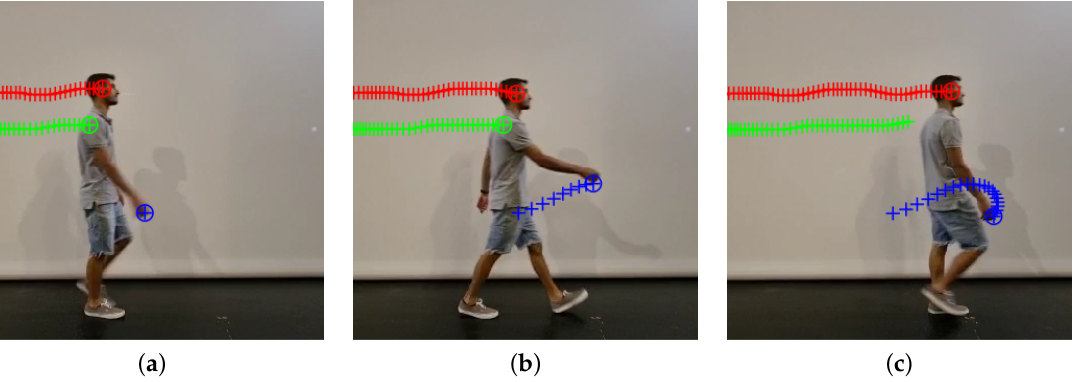
Figure 11. Process for the video analysis of a walking man, tracking motion of the head (red markers), shoulder (green markers) and right hand (blue markers) ( a ) at the beginning of walking; ( b ) during walking, hand forward; ( c ) during walking, hand